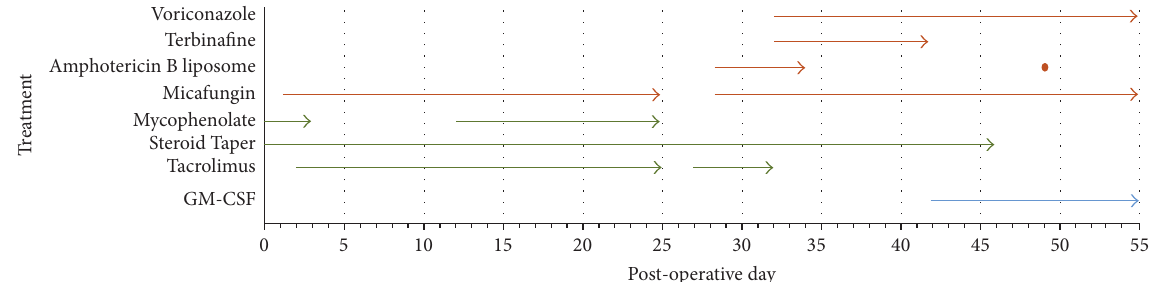
Figure 1: Antifungal agents and immunosuppression